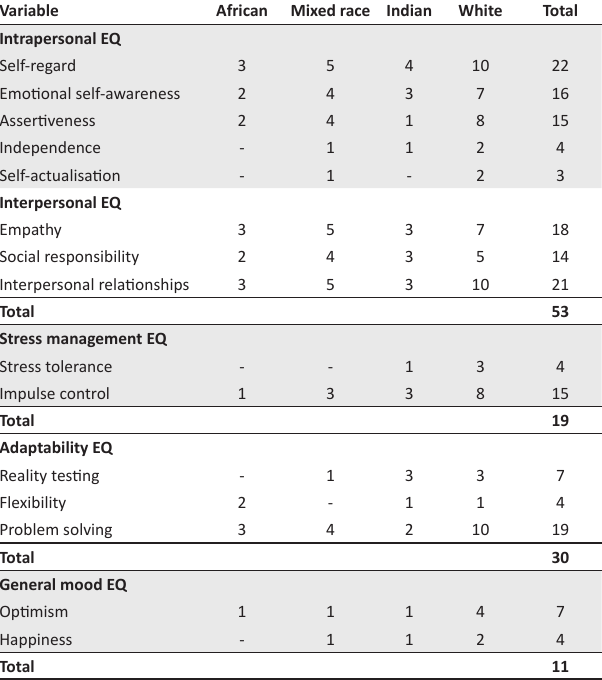
TABLE 8: Overall statements on EQ in women leaders in HEIs.